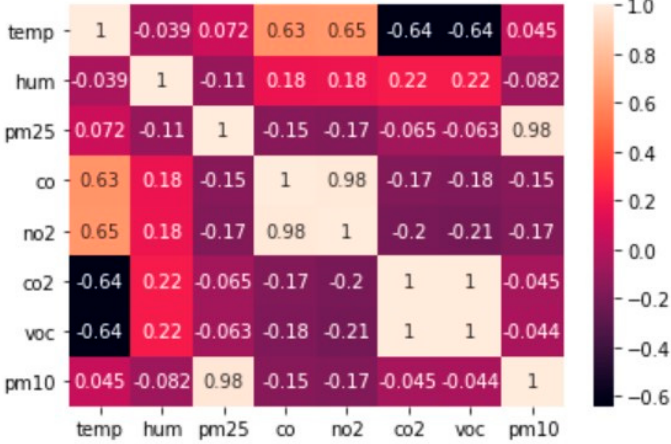
Figure 3. Pearson correlation between parameters.